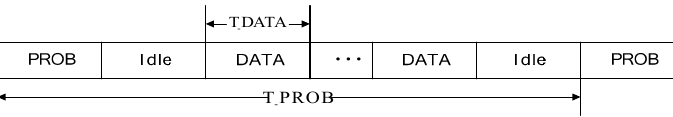
Figure 5. The diagram of T_DATA and T_PROB.